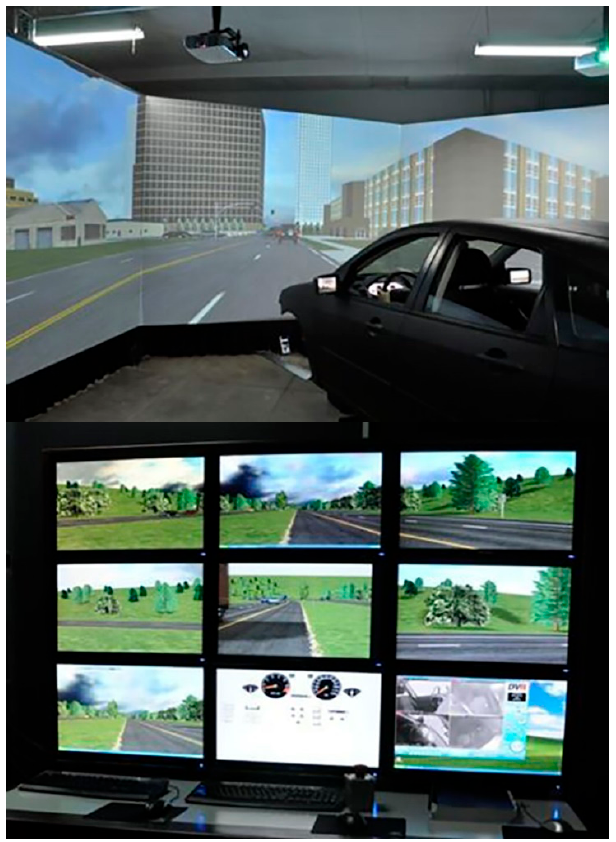
Figure 1. The Beijing Jiaotong University (BJTU) driving simulation system.